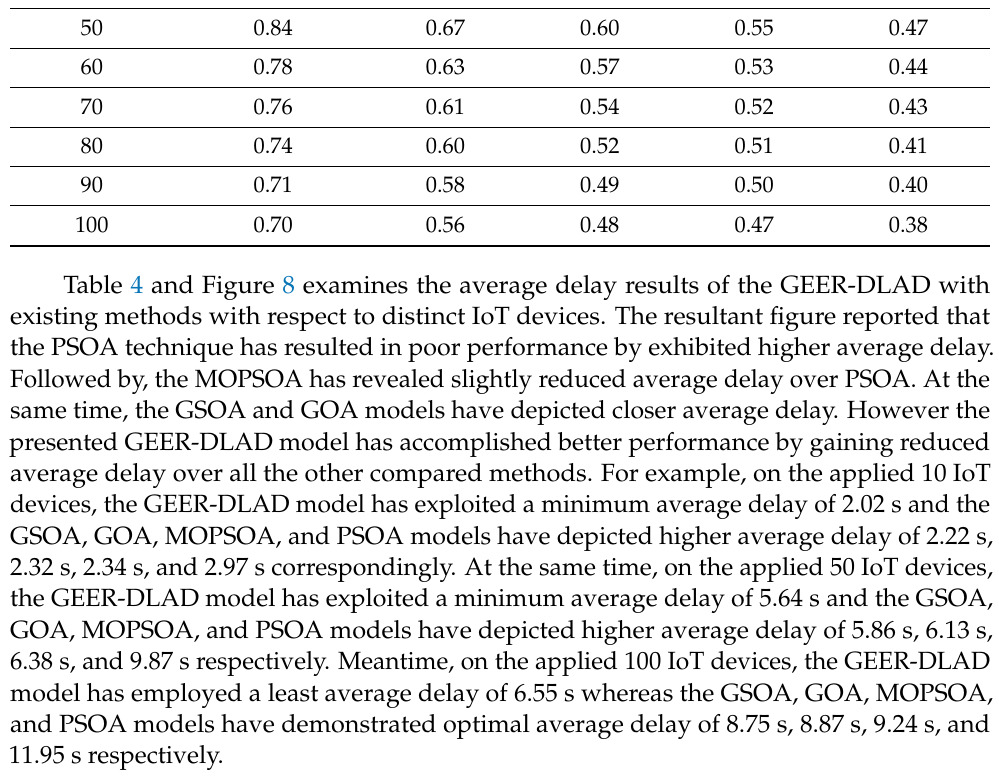
Table 4. Result Analysis of Existing with Proposed GEER-DLAD Method in terms of Average Delay (s). No. of